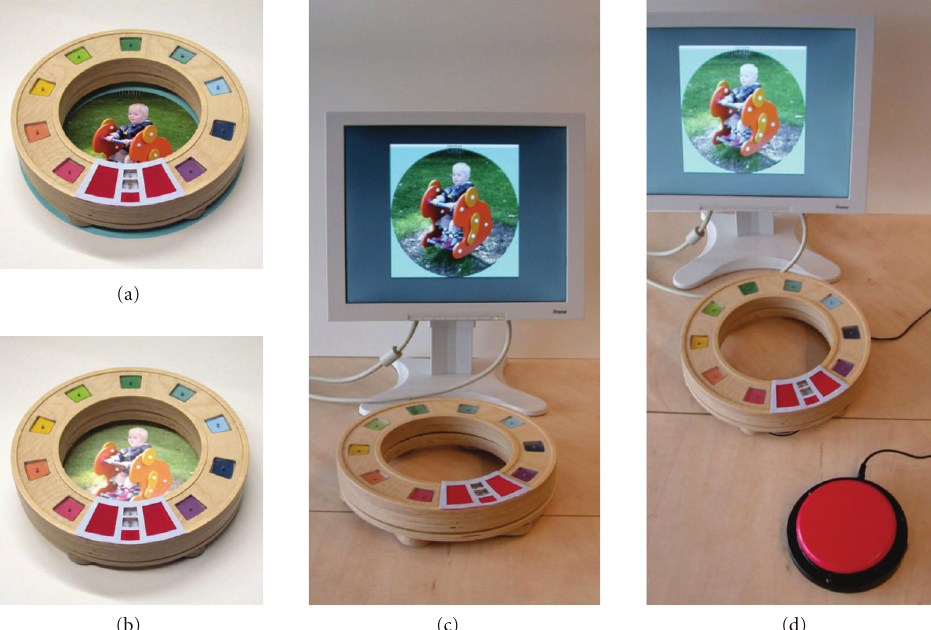
Figure 2: The E-Scope in its various configurations: (a) on the floor with pictures (top-left), (b) on a table with an integrated screen (bottom-left, mockup), (c) with a separate screen (middle), and (d) with an additional input device